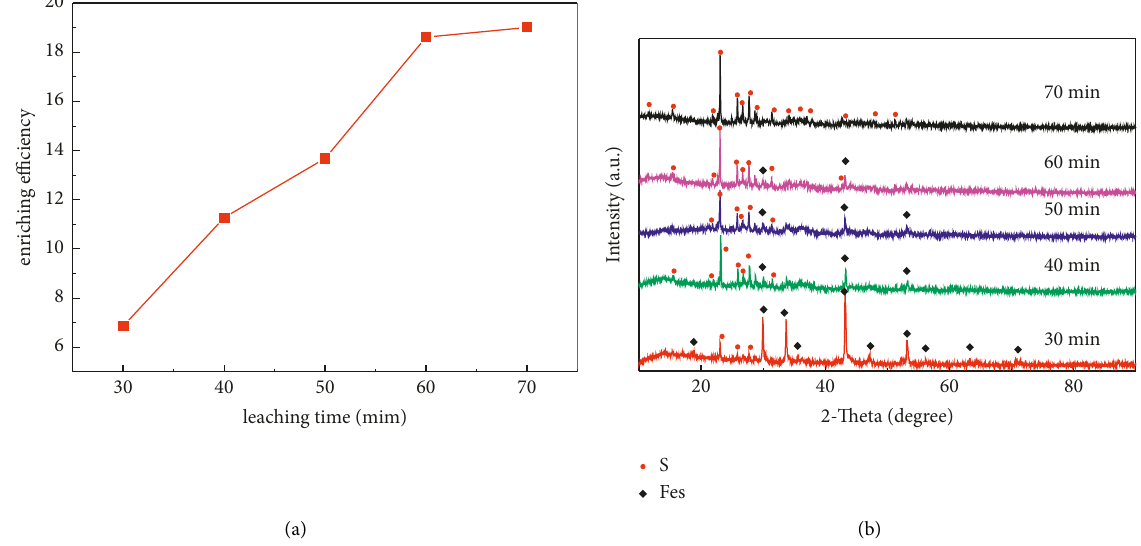
Figure 8: Effects on (a) Pt enriching efficiency and (b) XRD analysis of leaching residue with different time periods.